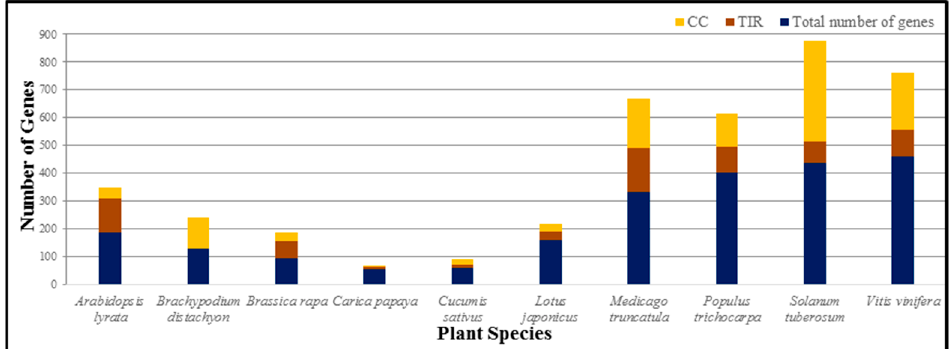
Figure 1. Presence of nucleotide-binding-site (NBS)-encoding R genes in different plants. Toll interleukin 1 receptor nucleotide-binding and leucine-rich repeat (TIR-NB-LRR) and coiled-coil-NB-LRR (CC-NB-LRR).